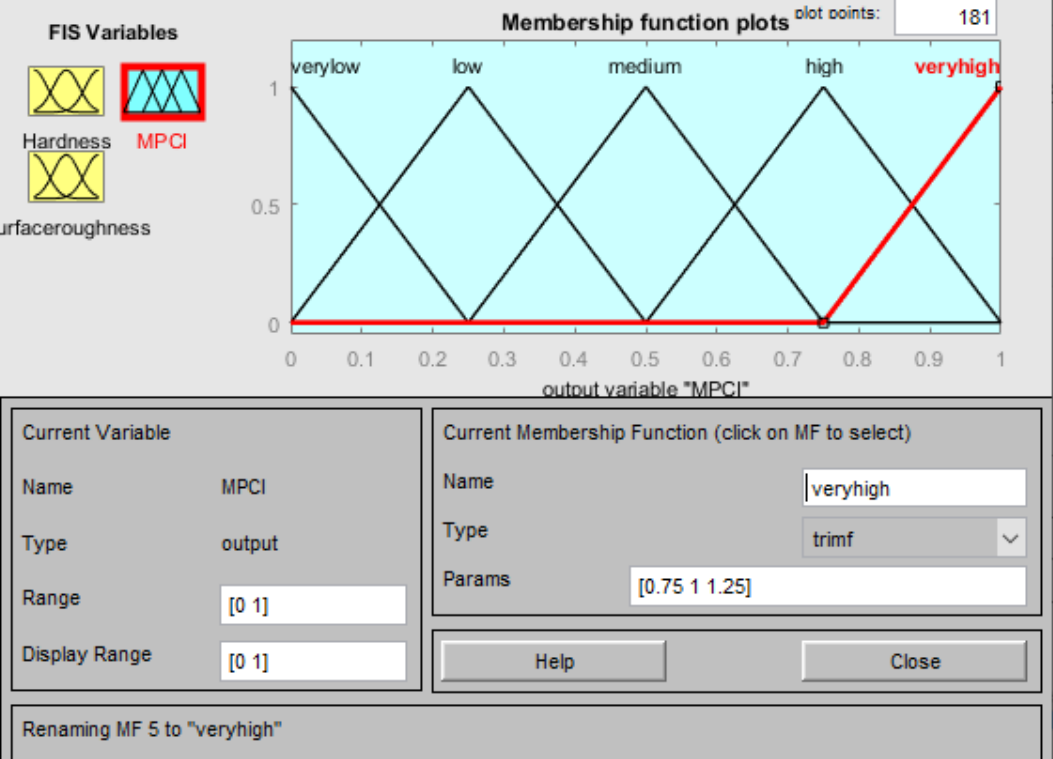
Figure 8. Membership function for the surface roughness.